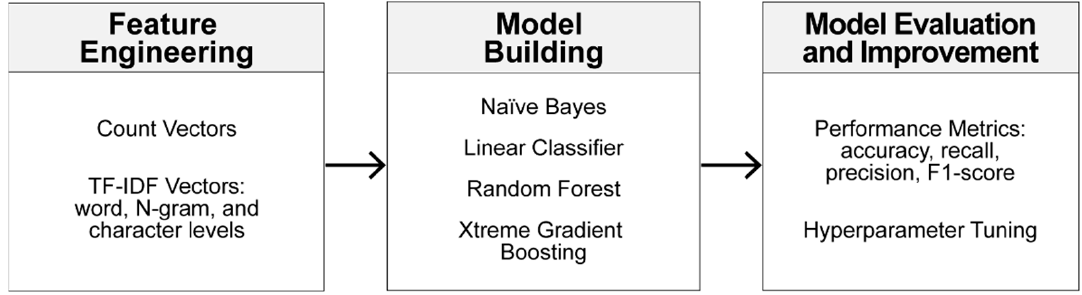
Figure 7. Machine learning-based text classification method for extraction module development.